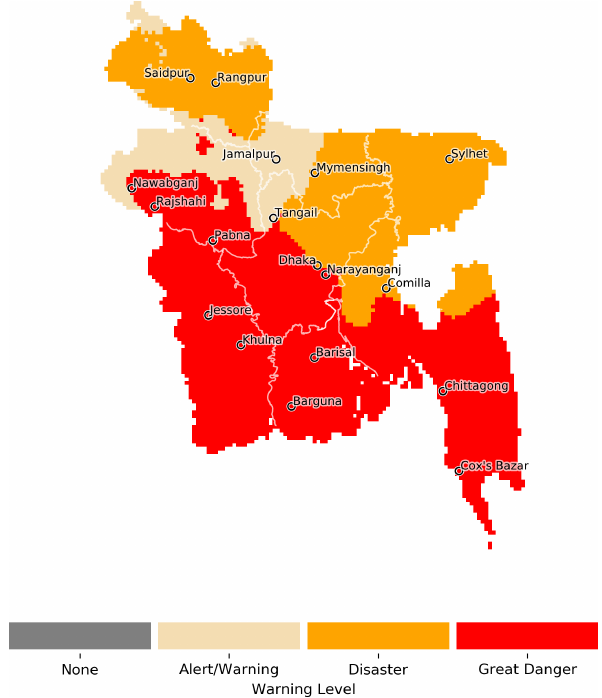
Figure 6. Example warning status given an impending landfalling tropical cyclone over Bangladesh. These warnings represent the most effective action minimising the loss as defined in Table